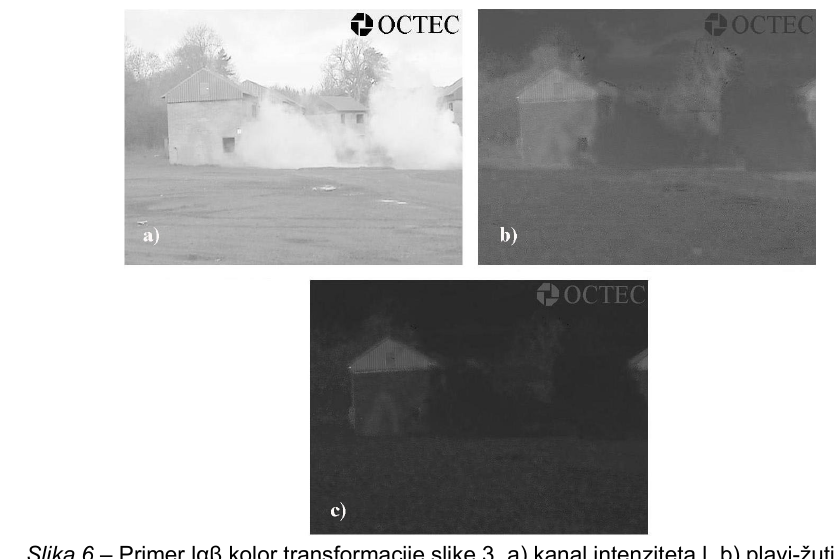
Figure 6 – The l αβ representation of the image in Figure 1, a) intensity channel l, b) the blue-yellow channel α and c) the red-green channel